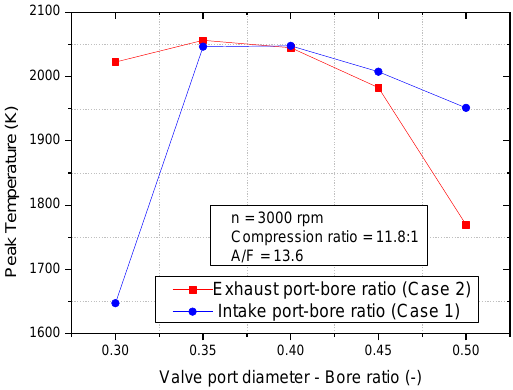
Figure 13. Peak firing temperature versus VPD/B.